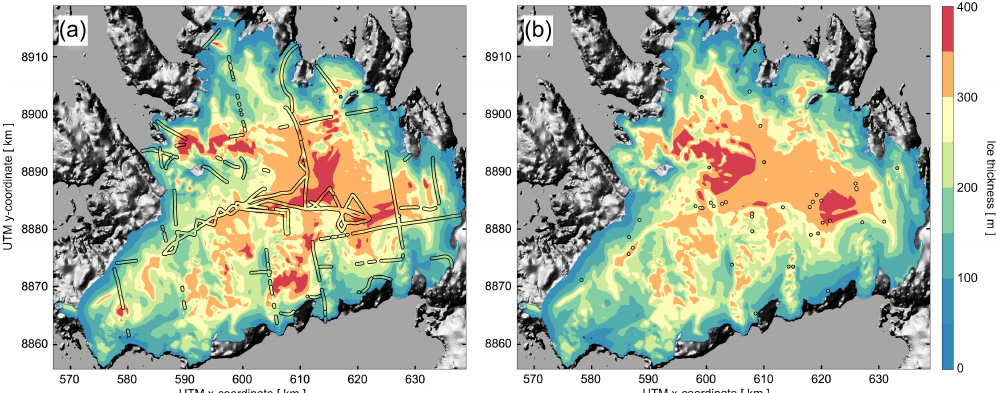
Figure C1. Ice-thickness map for VIC as in Fig. 4 based on the 2003–2013 WRF-SMB field using all (a) or only 1% (b) of the thickness measurements.